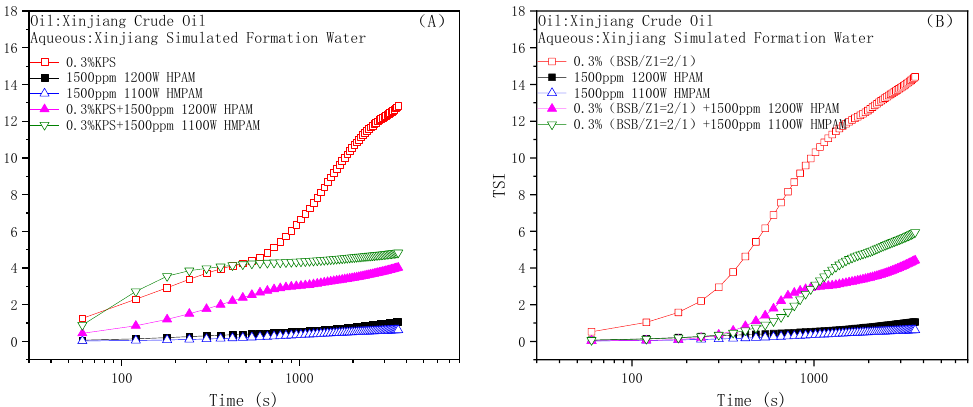
（B） Figure 9. Effects of HPAM and HMPAM on the interfacial dilational modulus of KPS ( A ) and BSB ( B ).